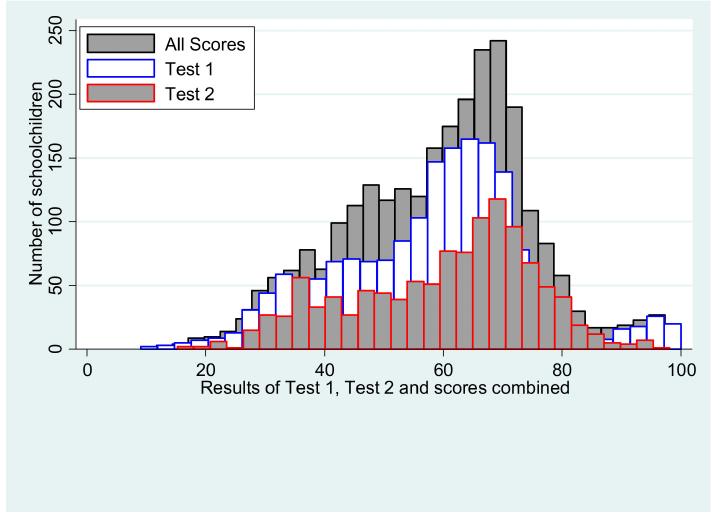
Figure 2. Average performance test scores for both Test 1 and Test 2 and